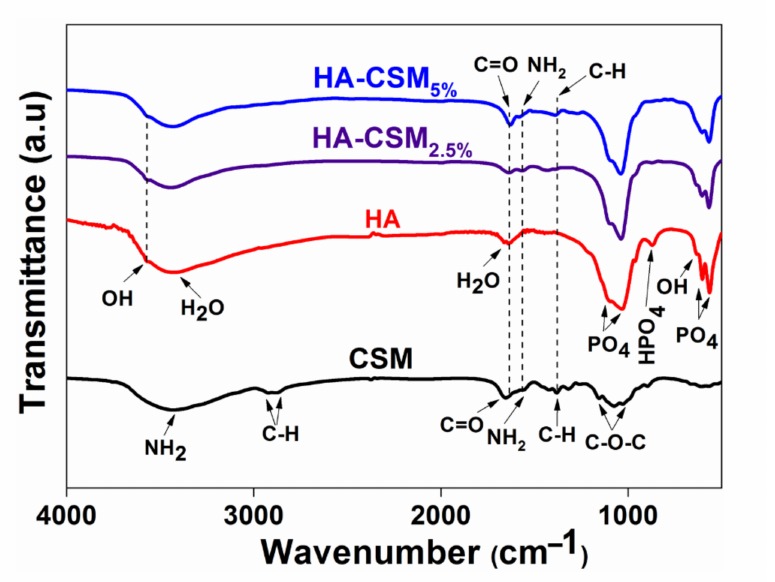
Figure 2. FTIR spectra of chitosan (CSM), hydroxyapatite (HA), and hydroxyapatite-chitosan com- posites (HA-CSM).